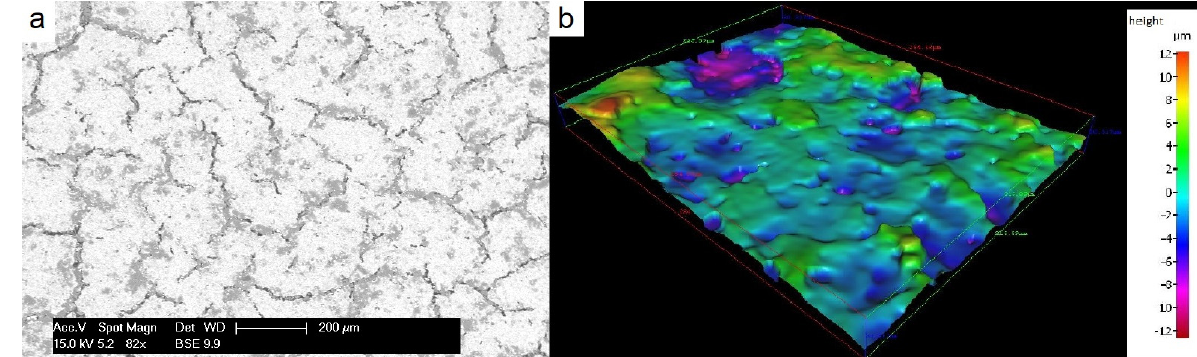
Figure 6 . ( a ) SEM image of the surface of protective layer coated on 304L stainless steel substrate, crosslinked at 200 °C and pyrolyzed at 700 °C in argon; ( b ) 3D topography measurement of the layer.